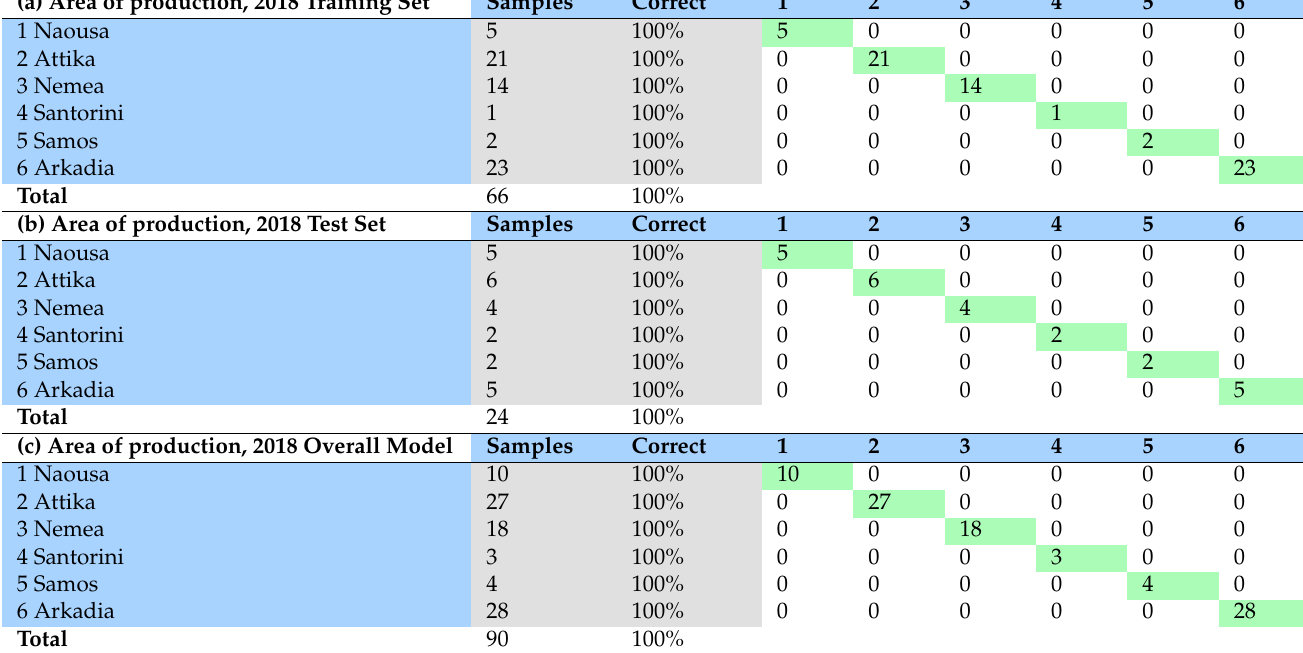
Table 9. Misclassification tables produced for the O2PLS-DA models of the wine samples of 2018 classified regarding area of production, where ( a ) training set, ( b ) test set, ( c ) overall